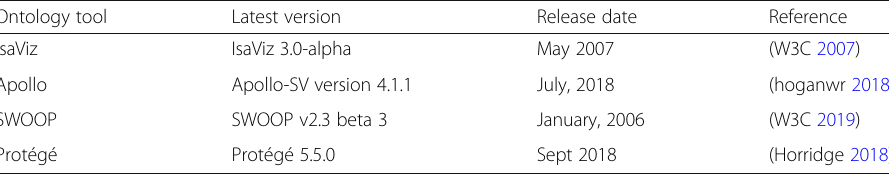
Table 4 Ontology Tools, Latest Version, and Release Date Ontology tool